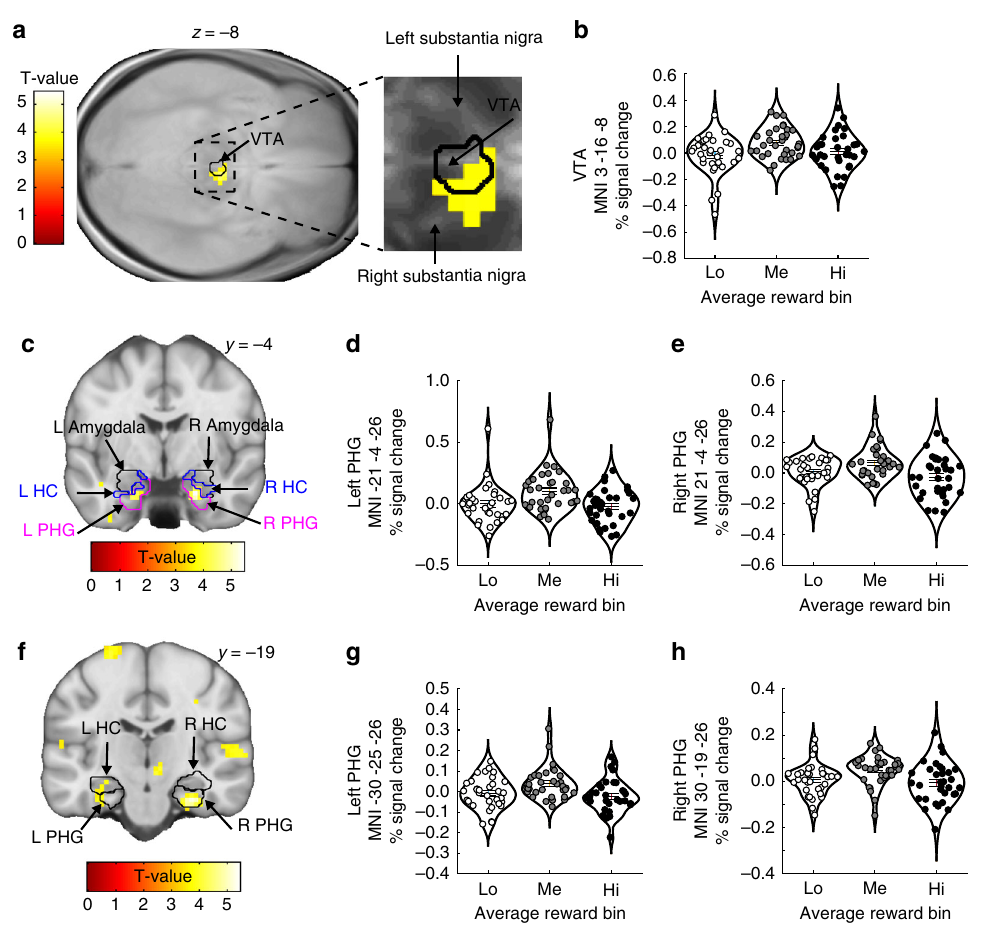
Fig. 4 BOLD signal as a function of the average reward level. BOLD signal in the VTA ROI ( a , b ), and the HC/PHG ROIs ( c – h ) was modulated in a nonlinear fashion with increasing levels of average reward. For display purposes, the violin plots show the average % signal change extracted from 3 mm spheres centered on peak voxel coordinates for each signi fi cant activation cluster. The horizontal lines indicate mean ± SEM. The BOLD signal is shown using an uncorrected threshold of p < 0.001. VTA ventral tegmental area ROI, HC hippocampus ROI, PHG parahippocampal gyrus ROI. Amygdala amygdala ROI. Source data are provided as a Source Data fi le. T-statistics were obtained from t- tests. Table 3 BOLD signal correlating non-linearly (inverted U-shape) with changes in average reward levels in a priori ROIs and the amygdala ROI.